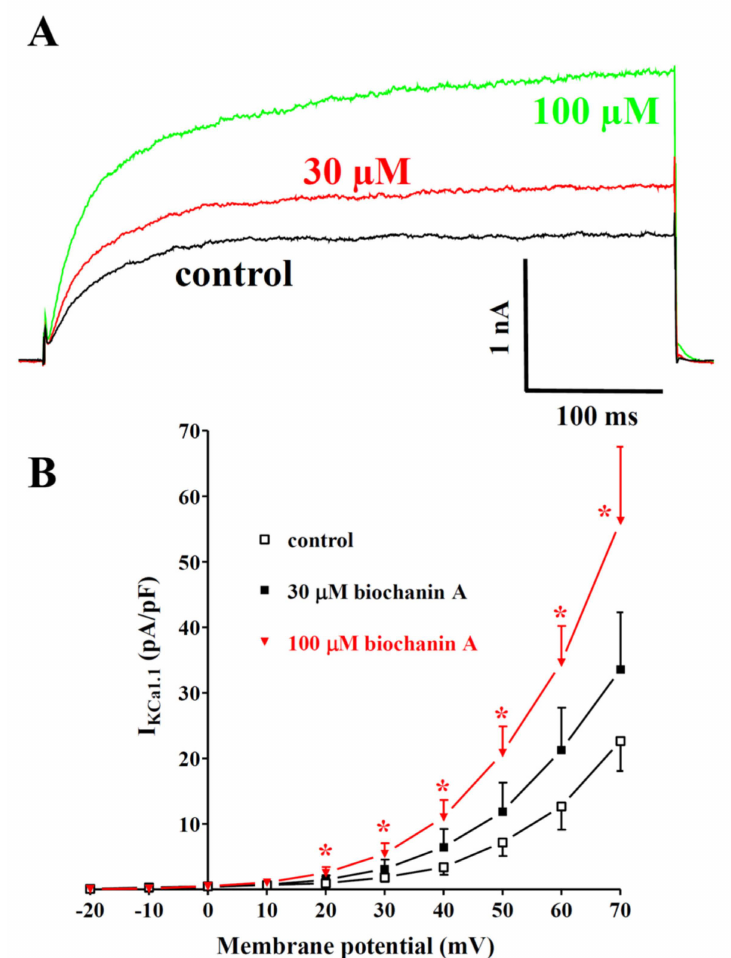
Figure 6. Effects of Dalbergia isolates on I KCa1.1 in single tail artery myocytes: ( A ) original recordings (average traces of 6 cells) of conventional whole-cell I KCa1.1 elicited with a 500 ms voltage step from V h -40 to 70 mV, measured in the absence (control) and presence of 30 and 100 µ M biochanin A; ( B ) current–voltage relationships obtained before the addition (control) and in the presence of various concentrations of biochanin A. On the ordinate scale, the response is reported as the current density in pA/pF. Data points are the mean ± SEM. * p < 0.05 vs. control; repeated measures ANOVA and Dunnett’s post hoc